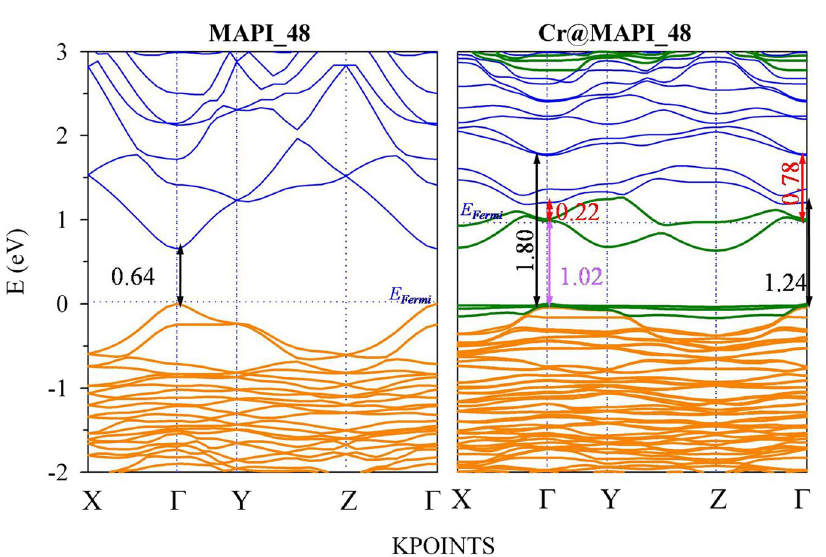
Figure 4. Projected band structure of MAPI_48 and Cr@MAPI_48 perovskites calculated with PBEsol + SOC along to main energy differences measured at Γ point (black, violet and red stand for VB-CB, VB-IGB and IGB-CB energy differences, respectively). Orange, Blue and Green colors stand for the main contribution of I, Pb and Cr atoms. The zero of energy has been set at the valence band energy, while blue dotted line is representing the Fermi level ( E Fermi